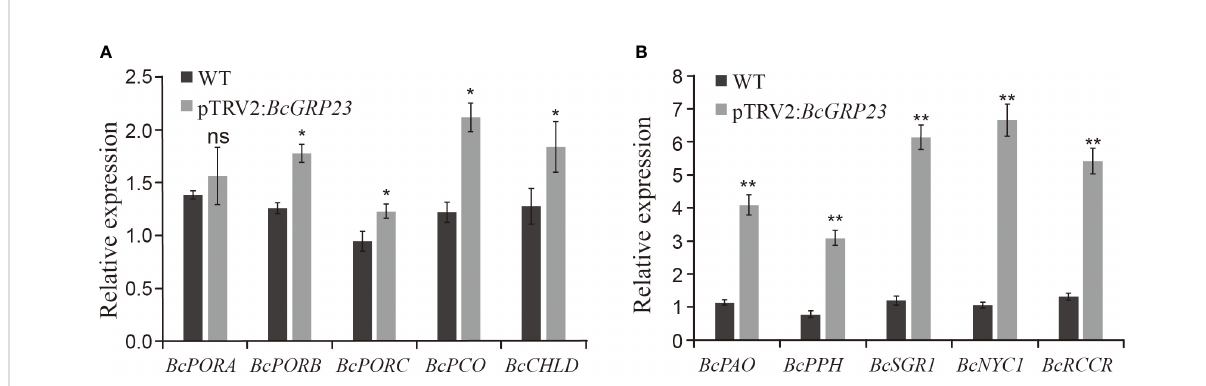
FIGURE 5 Expression of the genes related to chlorophyll biosynthesis (A) and degradation (B) in the petioles of the pTRV2: BcGRP23 knockdown lines. *Signi fi cant difference at the p < 0.05 level; **signi fi cant difference at the p < 0.01 level; ns , no signi fi cant difference (Student ’ s t -test).